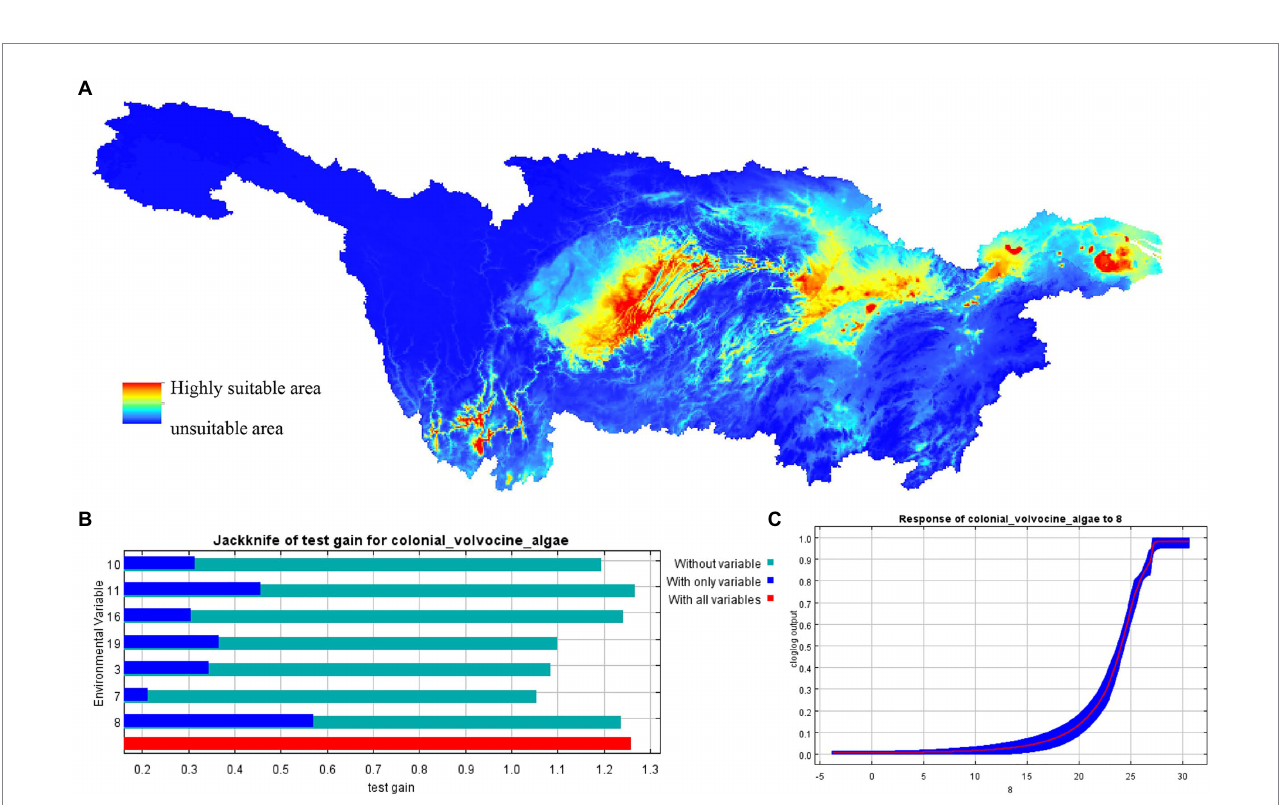
FIGURE 8 MaxEnt model predicted the distribution of colonial volvocine algae in current period. (A) Current distribution of CVA in the Yangtze River basin. (B) Jackknife analysis results showing most important environmental variables predicting potentially suitable distribution areas of CVA in the Yangtze River basin. (C) Response curves between the distribution probability of CVA and environmental variables